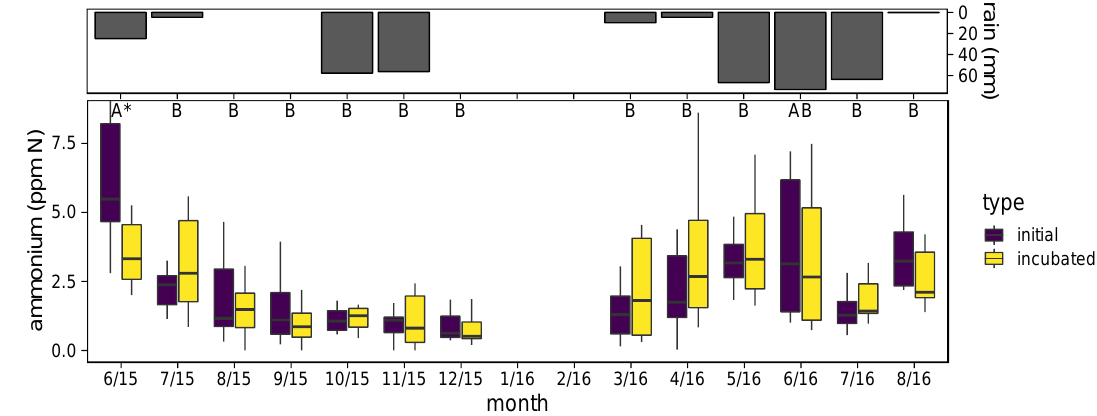
Figure 6. Soil extractable ammonium (parts per million nitrogen (ppm N) g − 1 dry soil) in initial and one-week incubations at seven bioswales sampled at two depths monthly ( n = 423) from June 2015 to August 2016, omitting two winter months. The letters above represent statistically significant differences among periods (two periods that share a letter are not statistically different), and * signifies periods where initial and incubated samples were statistically different. The bars at the top denote rain amounts during the one-week incubation periods.